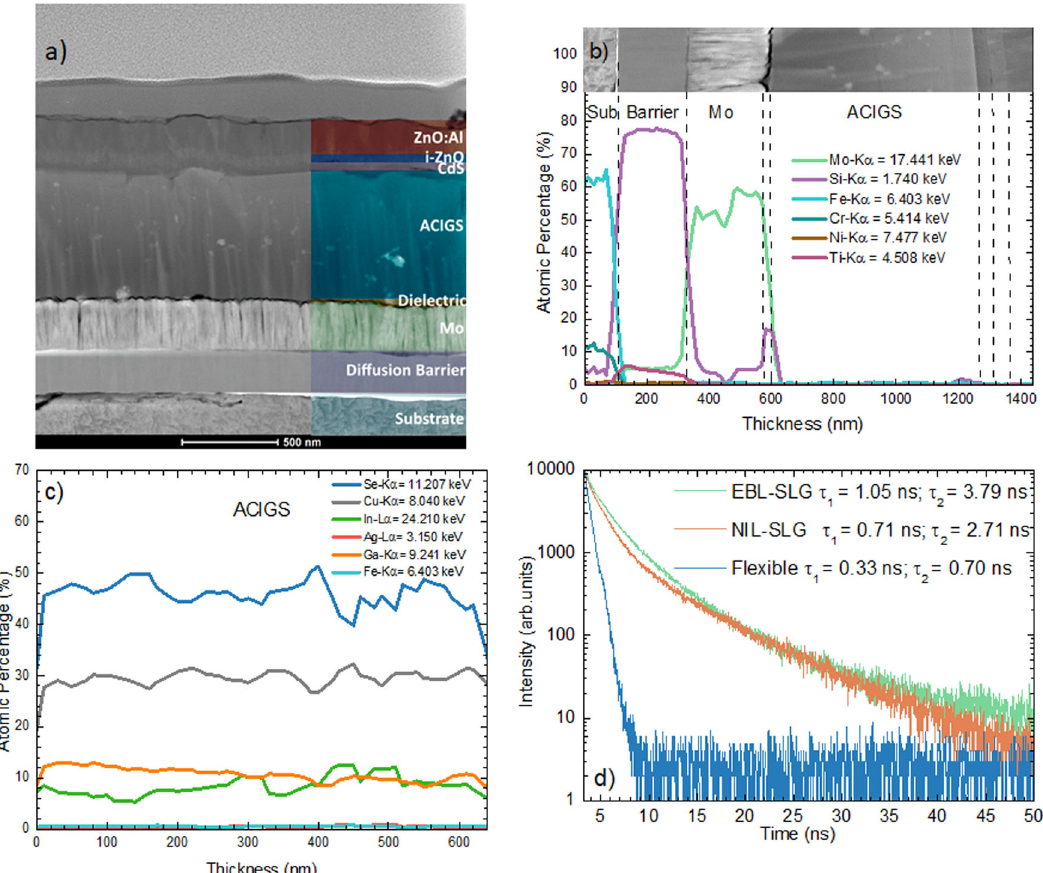
Fig. 5 Flexible device characterization by STEM and TRPL. STEM and EDS graph for the fl exible device a cross section STEM image for Flexible device with the corresponding layers of the device identi fi ed; b EDS line scan for the complete device. For clarity, only the elements present in the substrate, diffusion barrier and Mo contact are shown. The EDS line scan region is shown in the image; c EDS line scan in the ACIGS layer, where the corresponding elements together with Fe are shown; d room temperature TRPL decay for EBL-SLG, NIL-SLG and Flexible. A double exponential decays is observed for all